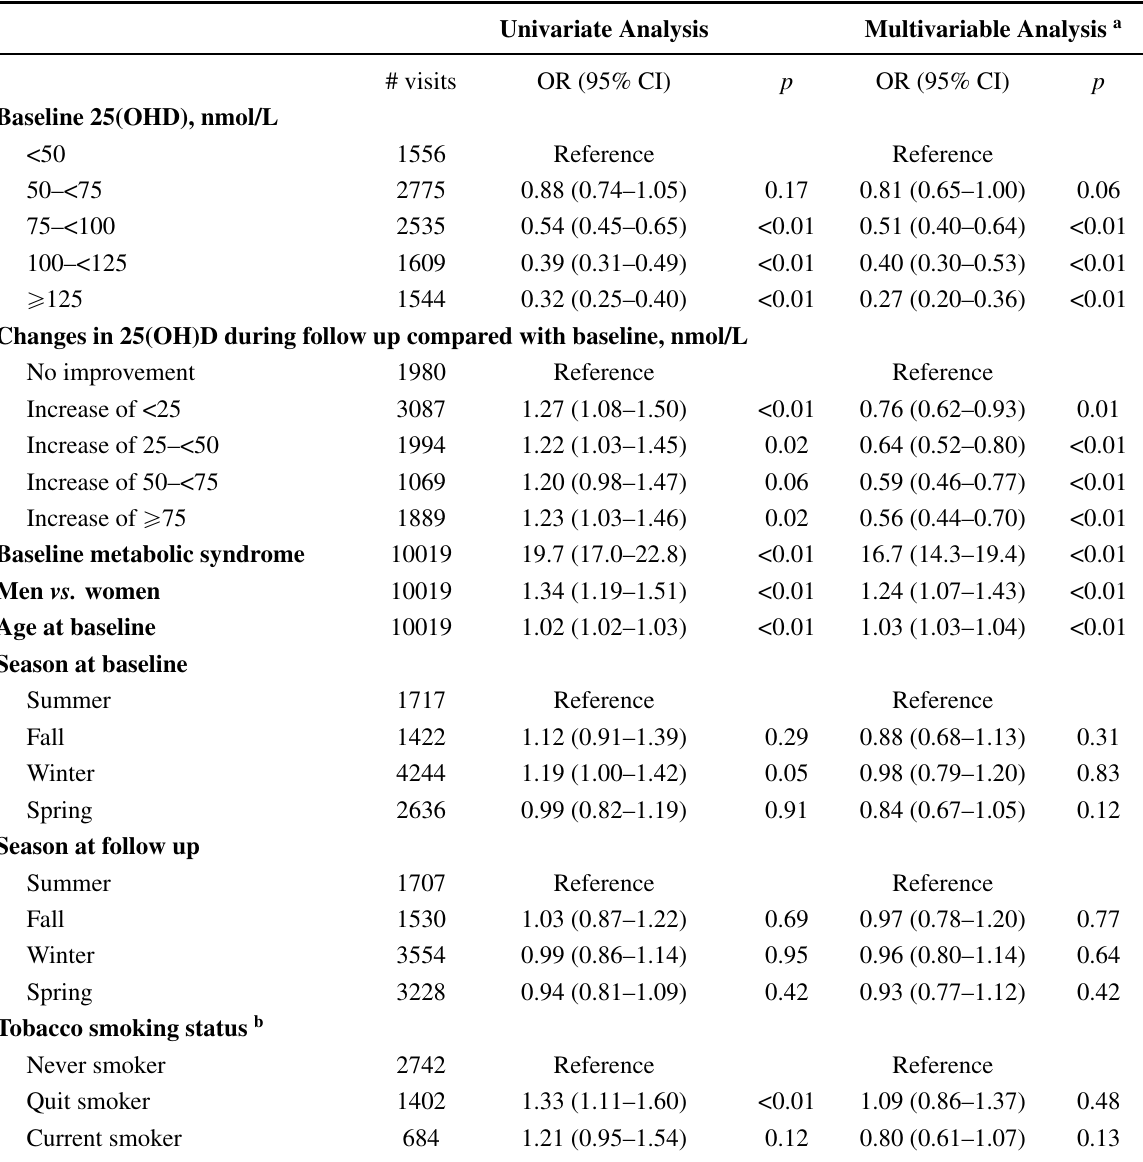
Table 2. Risk for metabolic syndrome at follow up among 6682 study participants with a total of 10,019 follow up